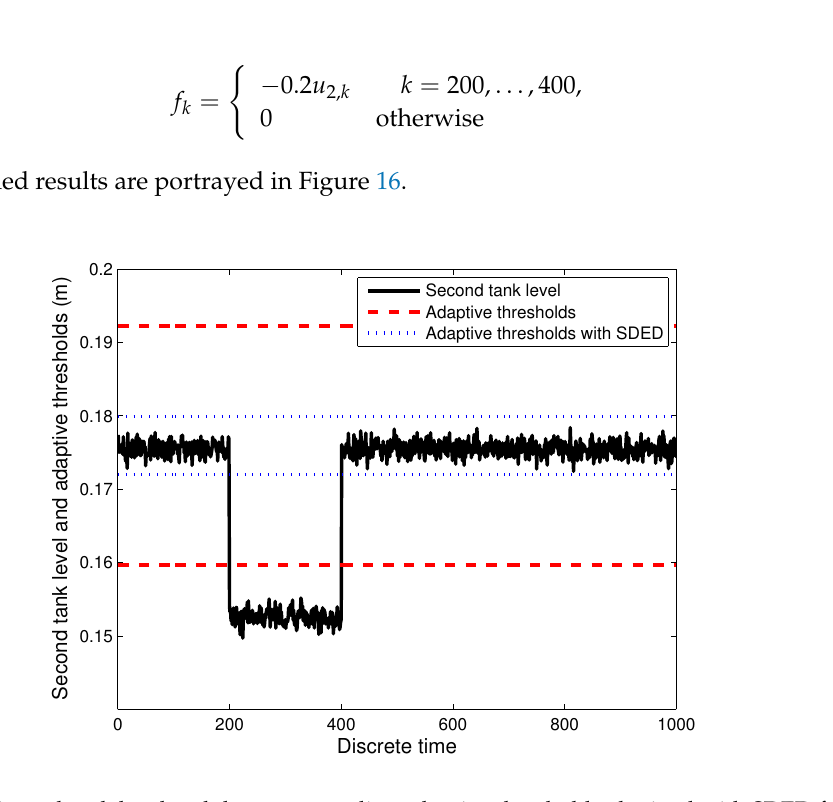
Figure 16. Second tank level and the corresponding adaptive thresholds obtained with SDED for the faulty system.